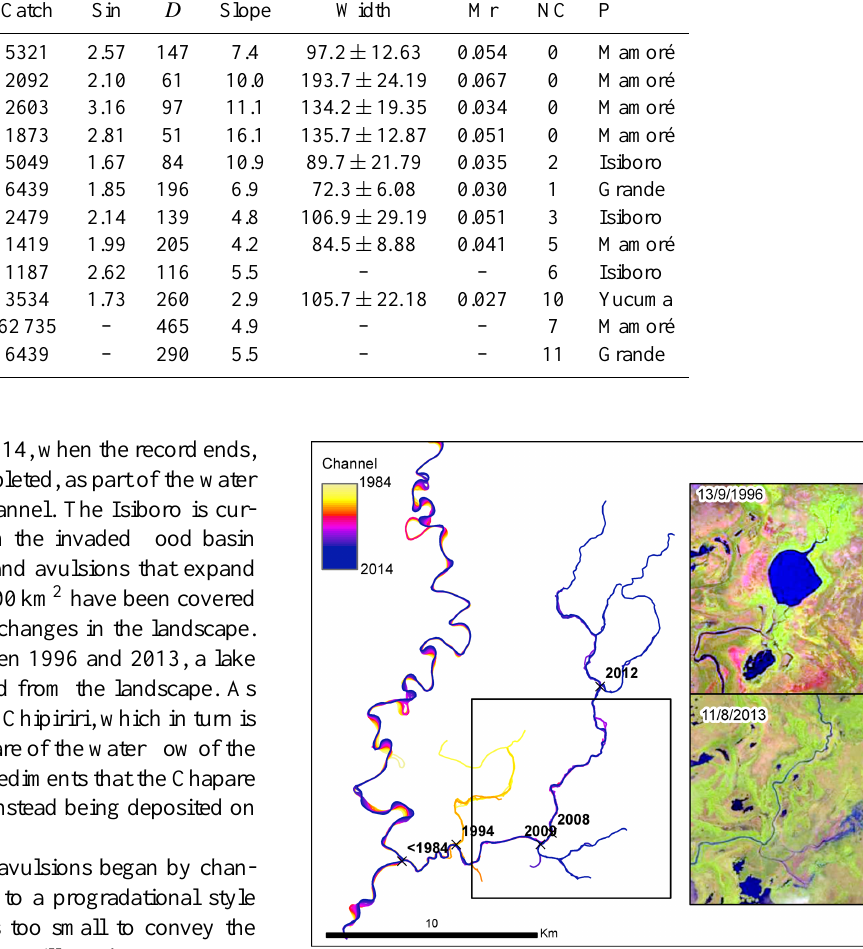
Figure 4. Avulsion of Río Isiboro. The Avulsion has a prograda- tional pattern where new crevasses and avulsions take place down- stream from the previous ones. Insets a and b show how the deposi- tion of sediments has reshaped the landscape, completely obliterat- ing a